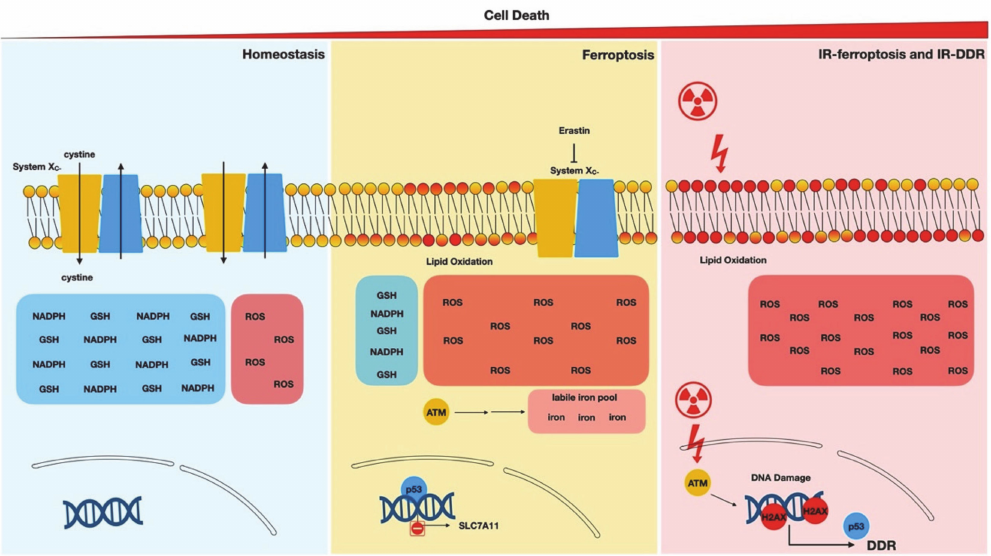
Figure 2. Ionizing radiation (IR) and DDR disrupt ferroptosis protection mechanisms. Imbalanced glutathione (GSH), NADPH, ROS (reactive oxygen species), labile iron, and lipid peroxidation are critical signatures of ferroptosis. Ionizing radiation (IR) increases ROS, lipid peroxidation, and stimulates canonical DDR to eradicate tumor cells